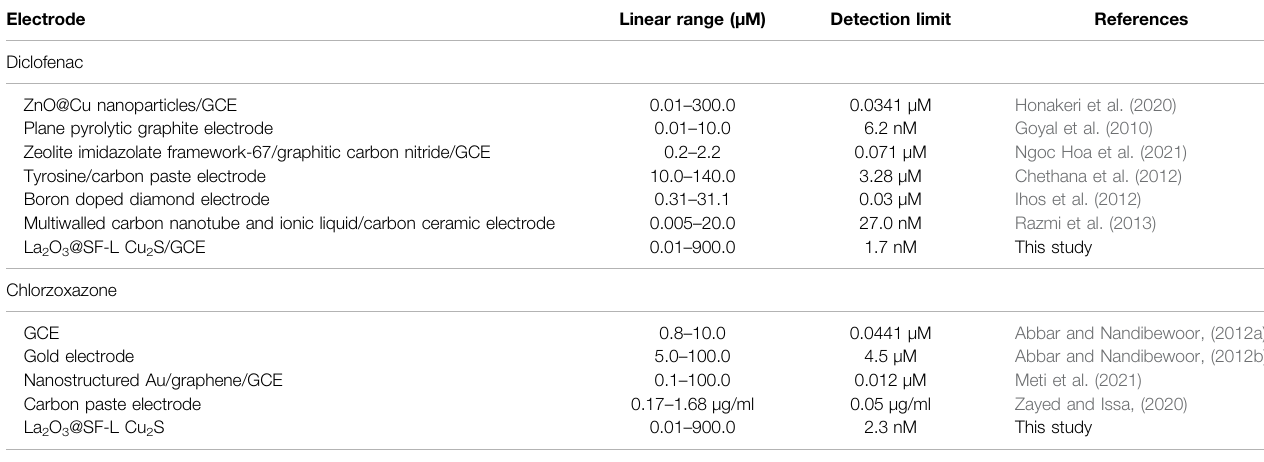
TABLE 2 | Performance comparison of La 2 O 3 @SF-L Cu 2 S/GCE for the simultaneous determination of diclofenac and chlorzoxazone with other electroanalytical methods.